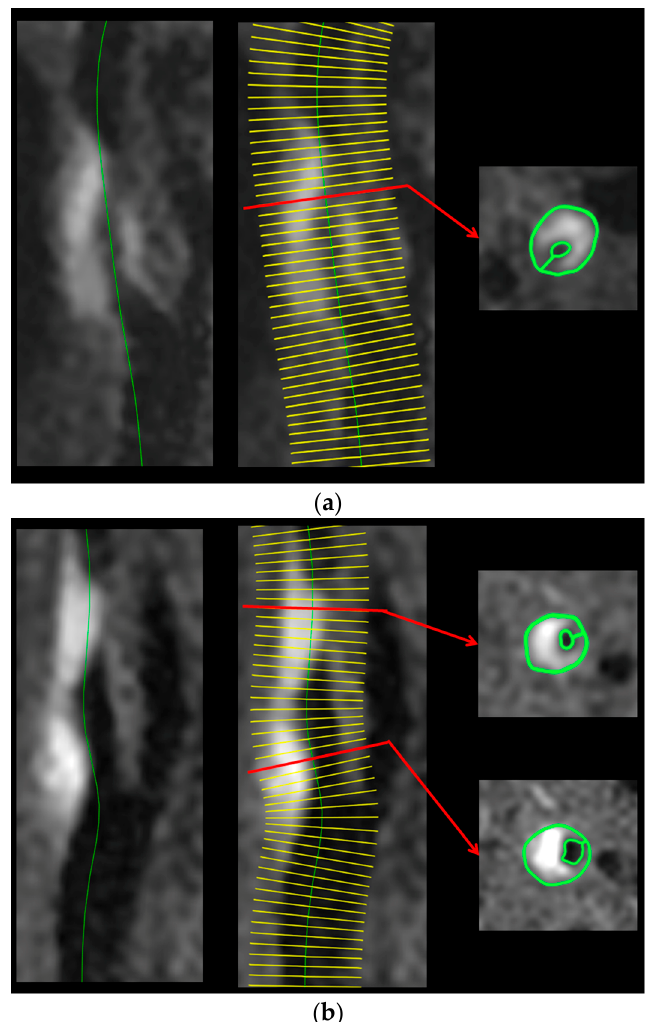
Figure 4. Preoperative three-dimensional fast spin echo T1-weighted magnetic resonance (3D FSE T1-weighted MR) plaque images of two patients with MES during exposure of the carotid arteries in endarterectomy. ( a ) The curved planar reformation is performed parallel to the long axis of the common and internal carotid arteries ( left ). The green line indicates the center line of the vessel lumen. On the image of the curved planar reformation, axial images with 1.0 mm thickness are reformatted as sections perpendicular to the center line ( middle ). Yellow lines indicate the position of each reformatted axial image. A reformatted axial image with the maximum POR and maximum plaque intensity (red arrows) are determined by tracing a plaque and vessel lumen of the common or internal carotid artery ( right , green lines). A 65-year-old man with asymptomatic right internal carotid artery stenosis exhibits identification of the image with the maximum POR and the image with the maximum plaque intensity; ( b ) Preoperative 3D FSE T1-weighted MR plaque images of two patients with MES during exposure of the carotid arteries in endarterectomy. The curved planar reformation is performed parallel to the long axis of the common and internal carotid arteries ( left ). The green line indicates the center line of the vessel lumen. On the image of the curved planar reformation, axial images with 1.0 mm thickness are reformatted as sections perpendicular to the center line ( middle ). Yellow lines indicate the position of each reformatted axial image. A reformatted axial image with the maximum POR and maximum plaque intensity (red arrows) are determined by tracing a plaque and vessel lumen of the common or internal carotid artery ( right , green lines). A 77-year-old man with symptomatic right internal carotid artery stenosis exhibits no identification of the image with the maximum POR ( upper ) and the image with the maximum plaque intensity ( lower ).